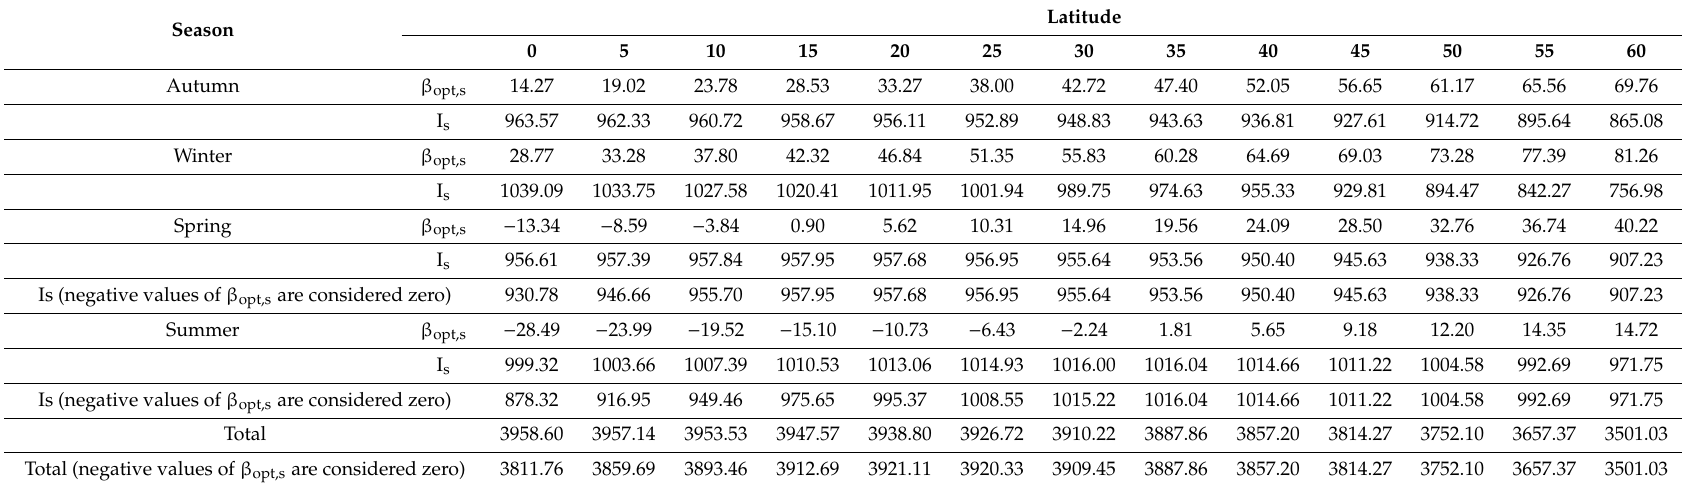
Table 8. The seasonally optimum tilt angles β opt,s and extraterrestrial radiation I s in kWh / m 2 for di ff erent latitudes.